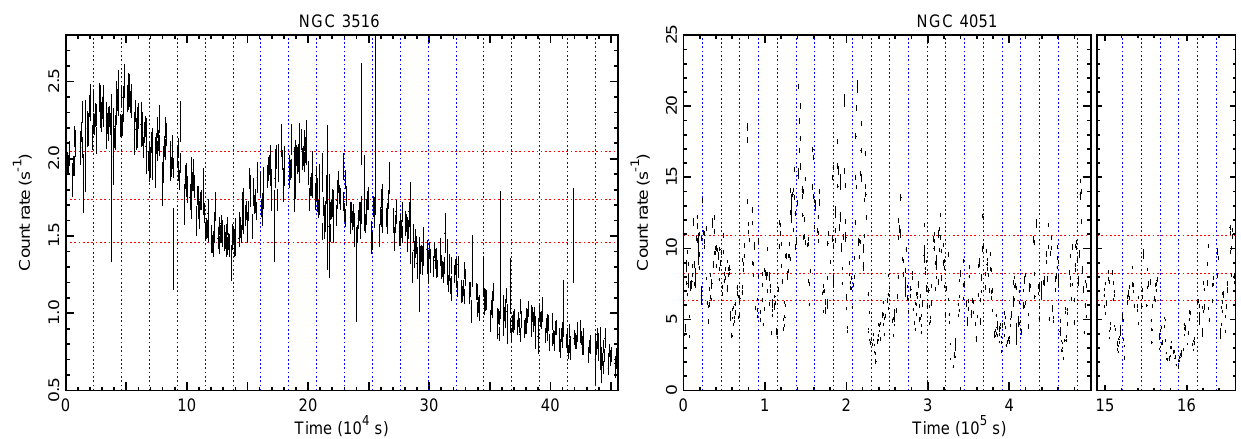
Figure 1: XIS light curves of NGC3516 and NGC4051 in 0.2–12.0 keV. The count rate is binned with 512 s. Horizontal red-dotted lines show the count rate intervals with which the intensity-sliced spectra were made (sec- tion 2.2). Vertical blue-dotted lines show the time intervals with which the time-sliced spectra were made (section 2.3).